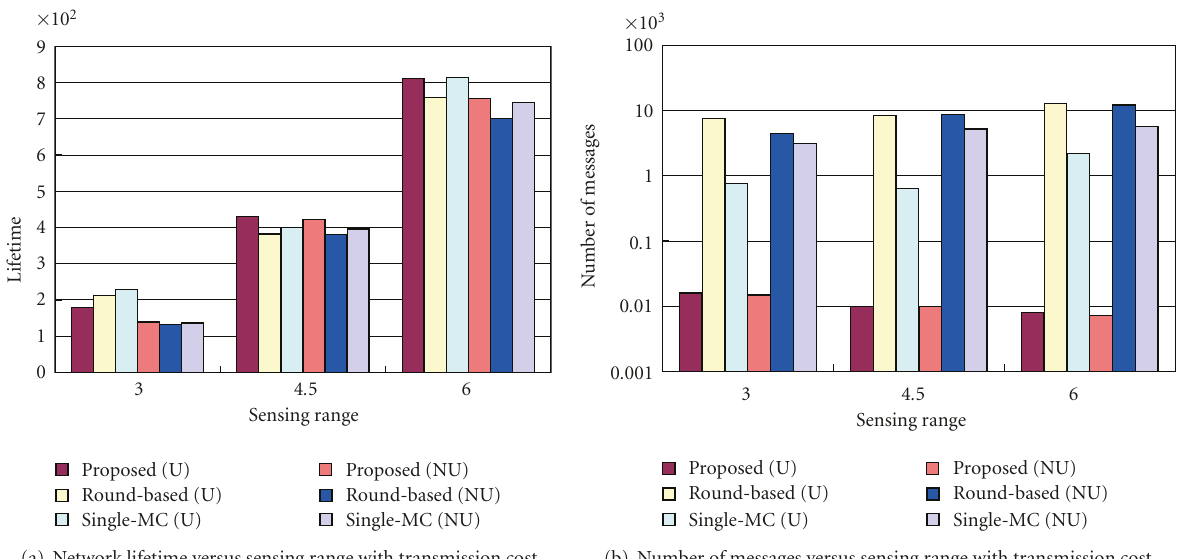
Figure 13: E ff ect of sensing range in homogenous sensing range